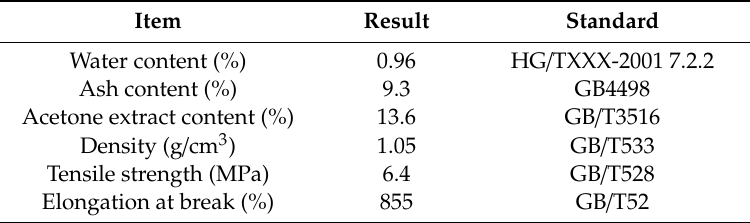
Table 2. Properties of crumb